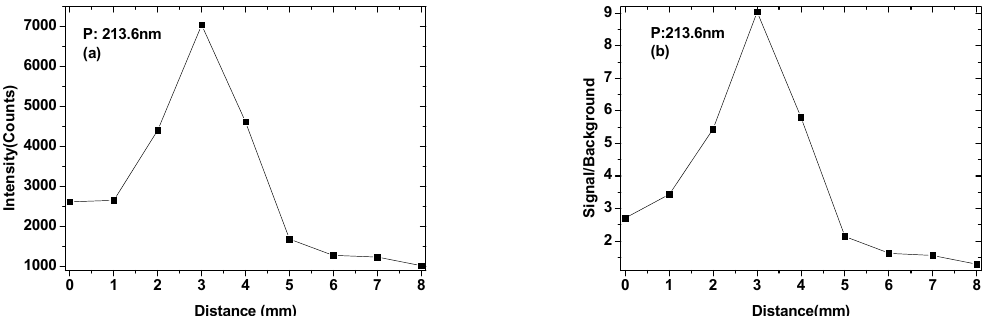
Figure 3. The line intensity of P 213.6 nm ( a ) and signal to background ratio ( b ) as a function of detection distance.